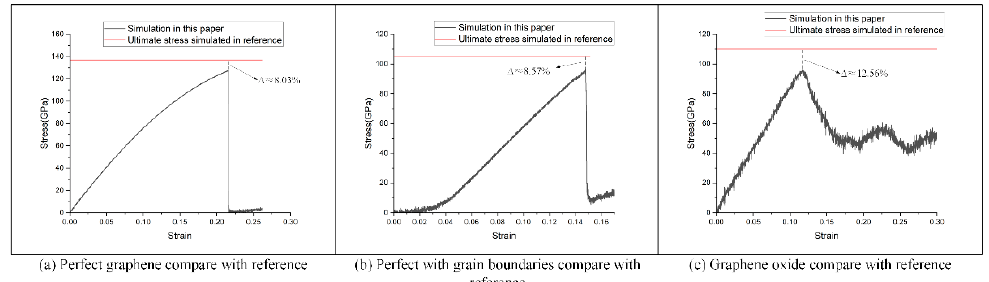
Figure 4. ( a ) Stress-strain curves of perfect graphene; ( b ) stress-strain curves of polycrystalline graphene; ( c ) stress-strain curves of GO.